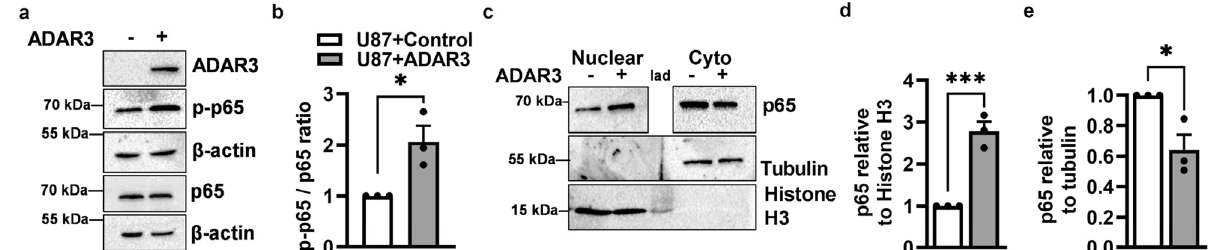
Figure 2. Increased phosphorylation and nuclear localization of the NF-κB p65 subunit upon ADAR3 expression. ( a ) Control (ADAR3−) and ADAR3-expressing (ADAR3+) U87 cells were lysed and subjected to immunoblotting with antibodies against ADAR3, p65, phosphorylated S356 p65 (p-p65), and β-actin. As phosphorylated and unphosphorylated p65 migrate at the same position on SDS-PAGE, expression of p-p65 and p65 was examined on independent immunoblots, with control detection of β-actin performed for each immunoblot. Blot is a representative image (replicate 2) of three biological replicates of the p65 and p-p65 immunoblots and one replicate of the ADAR3 immunoblot. Uncropped blot images are included in the supplementary information file. ( b ) Quantification of phosphorylated p65 protein (p-p65) to total p65 protein levels was determined relative to β-actin controls for each immunoblot. The relative p-p65/p65 ratios were normalized to the control cell line. Error bars represent the standard error of the mean (SEM) for three biological replicates. Statistical significance was determined using a two-tailed unpaired t-test. *p ≤ 0.05 ( c ) Cell equivalent amounts of nuclear and cytoplasmic fractions of control and ADAR3-expressing U87 cells were subjected to immunoblotting using antibodies against p65, tubulin and Histone H3. To determine the accuracy of the subcellular fractionation, the entire immunoblot was probed with Tubulin and Histone H3 antibodies. As cytoplasmic levels of p65 are significantly higher than nuclear p65 levels, to allow for exposure in the dynamic range and proper quantification, the entire p65 blot was incubated with primary antibody and exposed to capture the cytoplasmic p65 levels. Subsequently, the nuclear p65 immunoblot was cropped away from the cytoplasmic p65 samples and re-subjected to enhanced chemiluminescence detection for detection within the dynamic range. Blot is a representative image (replicate 1) of three biological replicates and uncropped blot images are included in the supplementary information file. ( d , e ) Quantification of the p65 level relative to Histone H3 in nuclear ( d ) and tubulin in cytoplasmic ( e ) fractions were normalized to the control cell line for three biological replicates. Error bars represent SEM. Statistical significance was determined by a